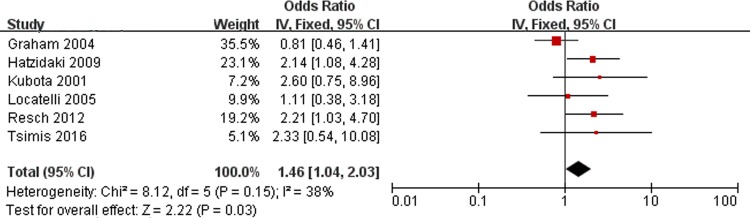
Fixed-effect model forest plot of the odds ratio of the association between RDS and PVL.The pooled OR of RDS is presented as a solid diamond at the bottom of the forest plot, the width of which represents the 95% CI.